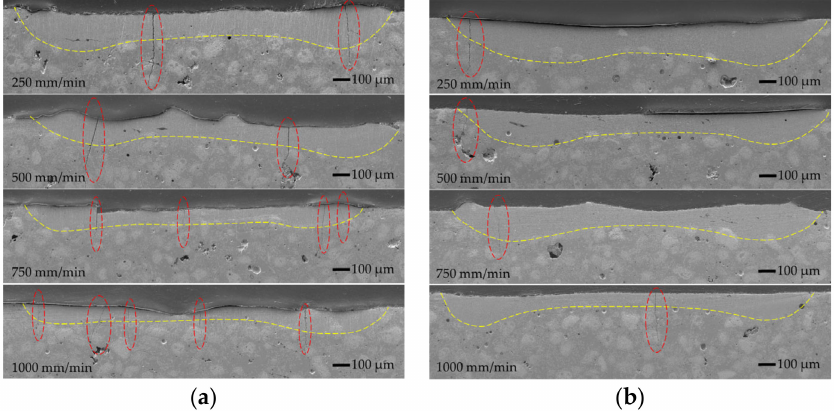
Figure 5. Cross-sectional SEM micrographs of molten pools oscillated with 2 mm amplitude without ( a ) and with ( b ) preheating and a varying laser operating speed between 250 and 1000 mm/min: red dotted ovals show the cracks.